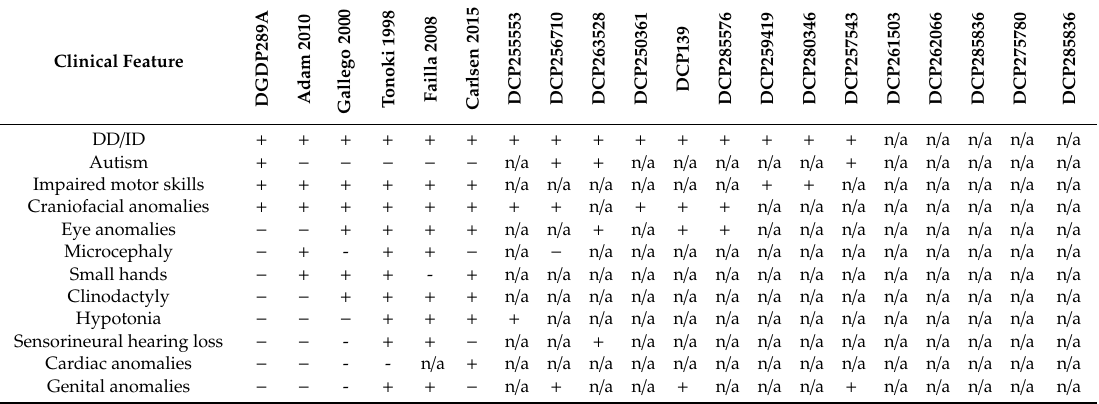
Table 4. Clinical features of patients with 12q12 microdeletions and microduplications.